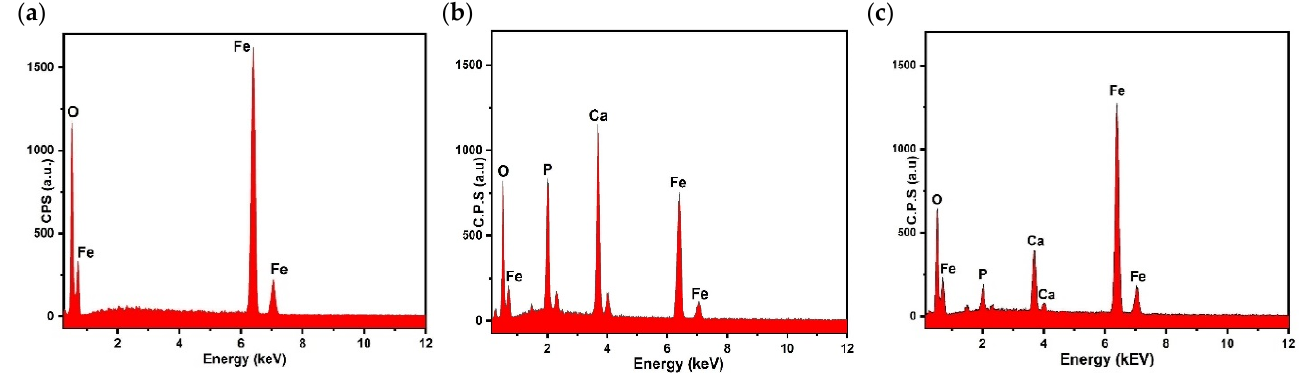
Figure 10. EDS spectra for the ( a ) bare SPION, ( b ) 50% SPION/HAp, and ( c ) 80% SPION/HAp.